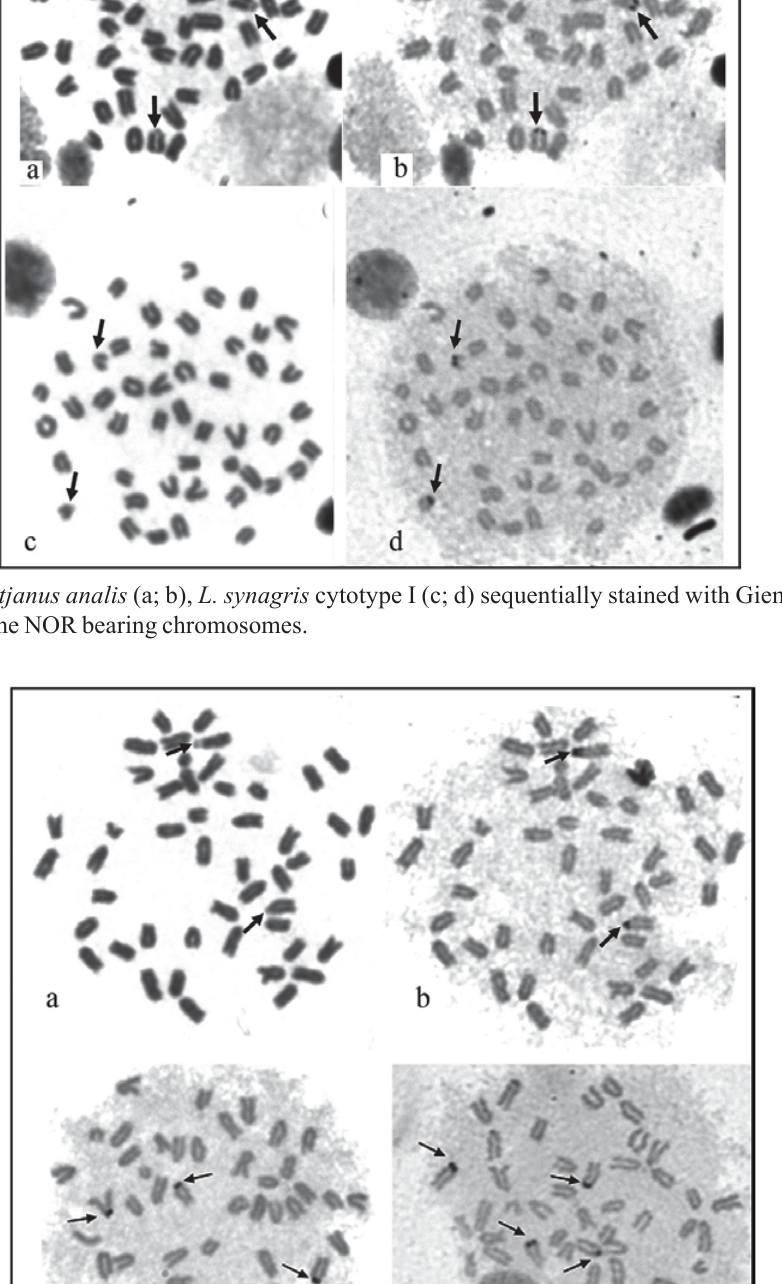
Fig. 4. Metaphases of Lutjanus griseus , with two (b), three (c) or four (d) Ag-NORs (arrows). In (a) the same metaphase as (b) previously stained with